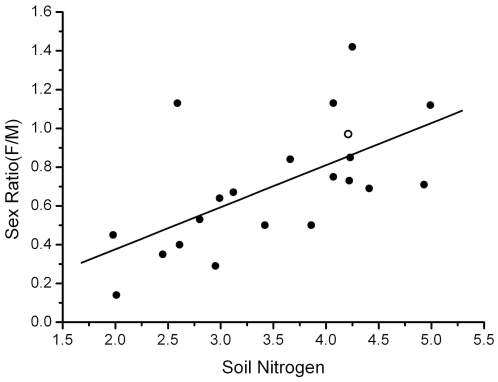
Correlation of soil nitrogen and sex ratio (F/M) of 20 populations on the islands (closed circle) and one population on the mainland (open circle), The Pearson correlation coefficient r = 0.615, P = 0.003.